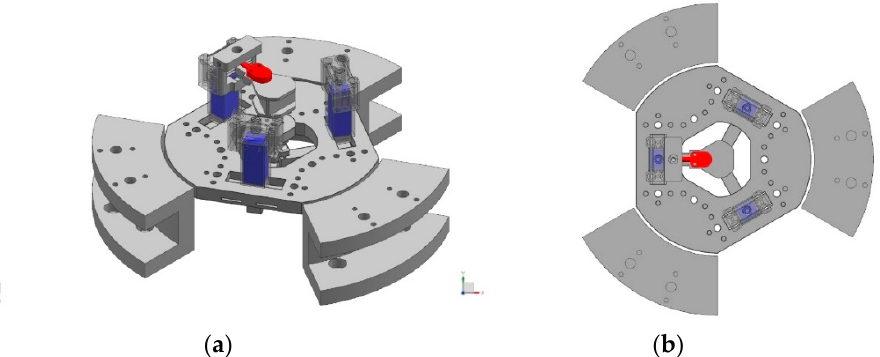
Figure 2. Out-of-plane actuators and sensors of the proposed spatial nanopositioner. ( a ) 3D view ( b ) top view.